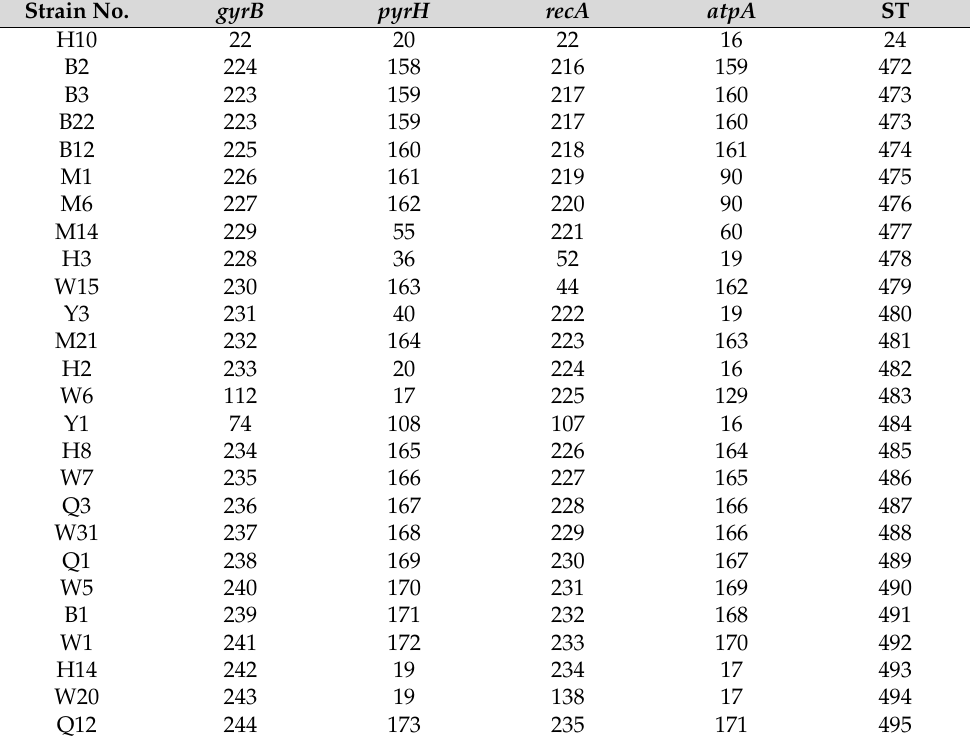
Table 2. The allelic profiles and STs of the analyzed isolates. Strain